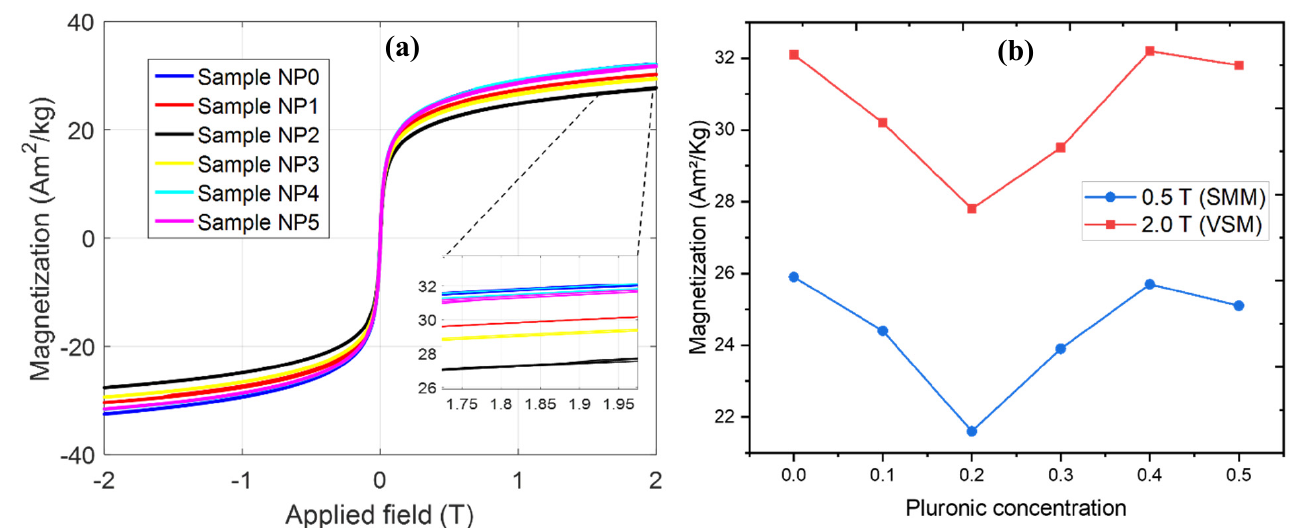
Figure 16. Magnetization measurements ( a ) of the six samples by VSM. The inset shows the saturation region, close to a magnetic field of 2 T. ( b ) Values of saturation magnetization versus Pluronic consent.